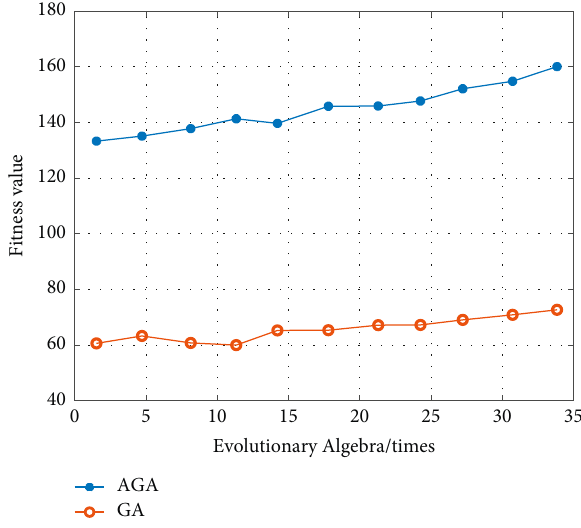
Figure 3: Convergence curve of the